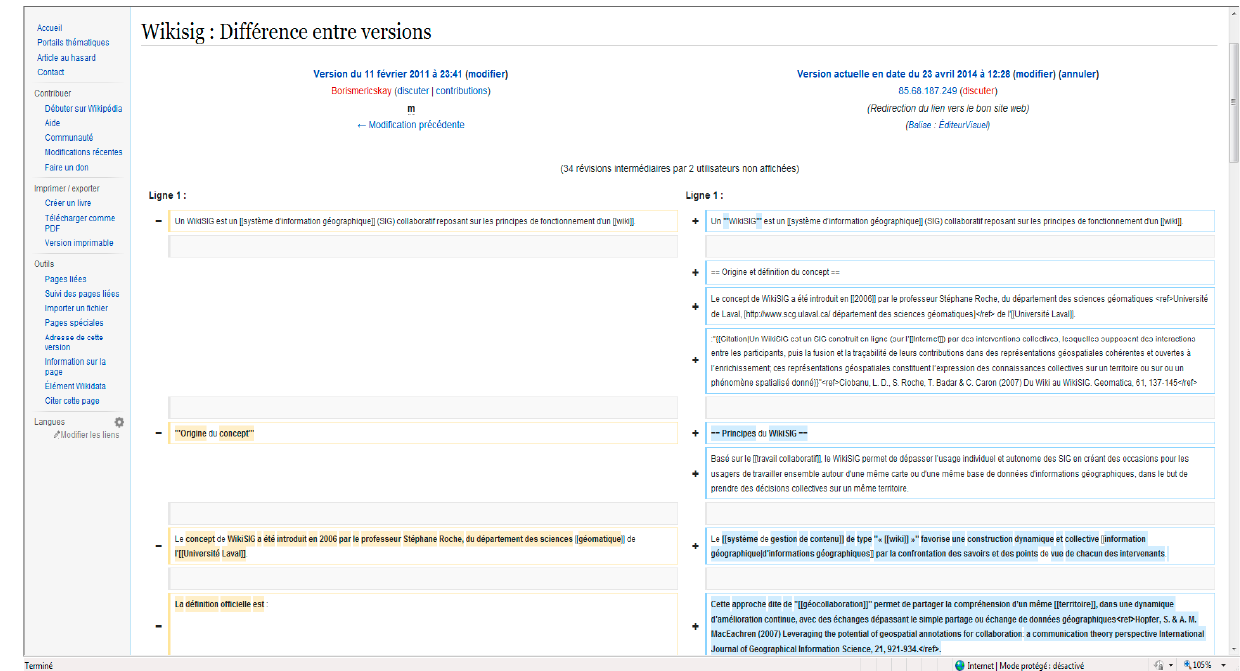
Figure 9. Diff function applied for comparing two texts in Wikipedia